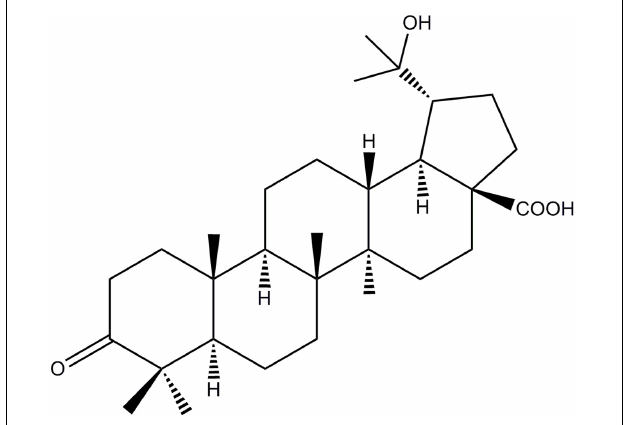
FIGURE 1 | Chemical structure of